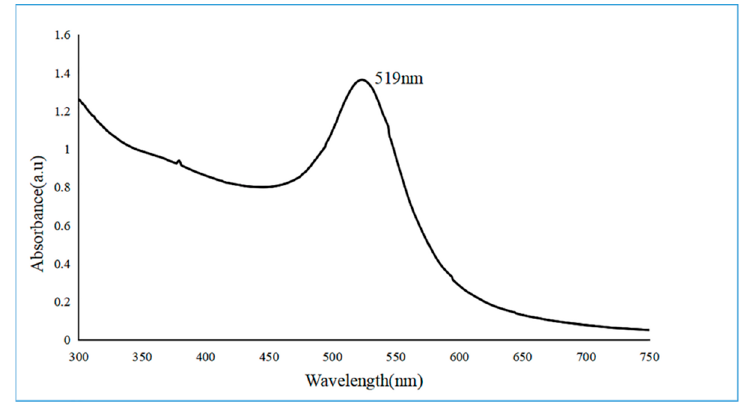
Figure 8. Ultraviolet – visible absorption spectra of gold nanoparticles.